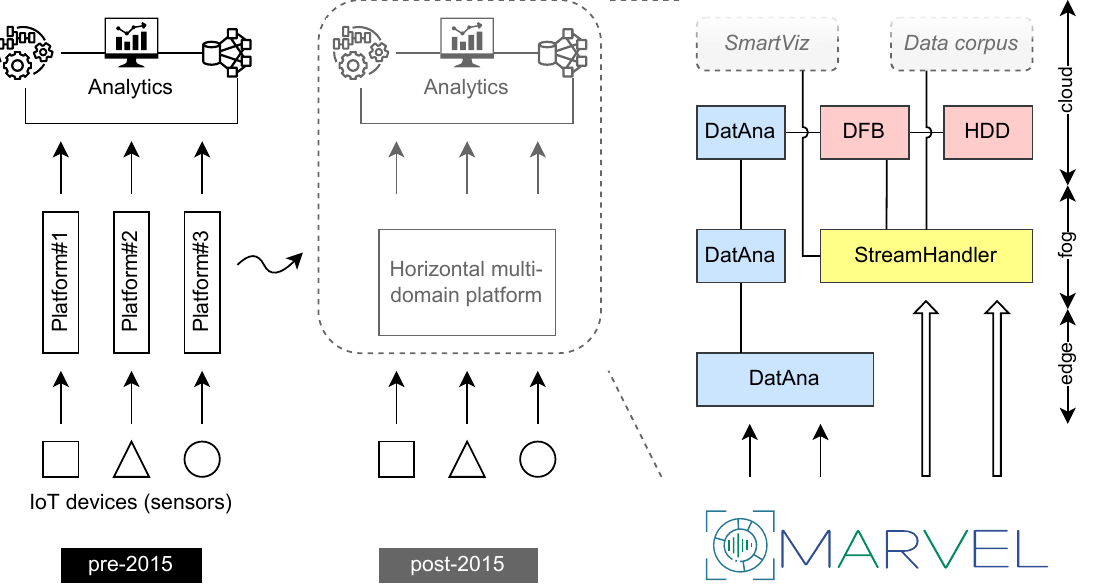
Figure 1. Transition of smart city data management and distribution systems from vertical silos to horizontal (cloud-based) platforms and positioning of the H2020 MARVEL project’s proposition for multi-layer Edge to Fog to Cloud (E2F2C)